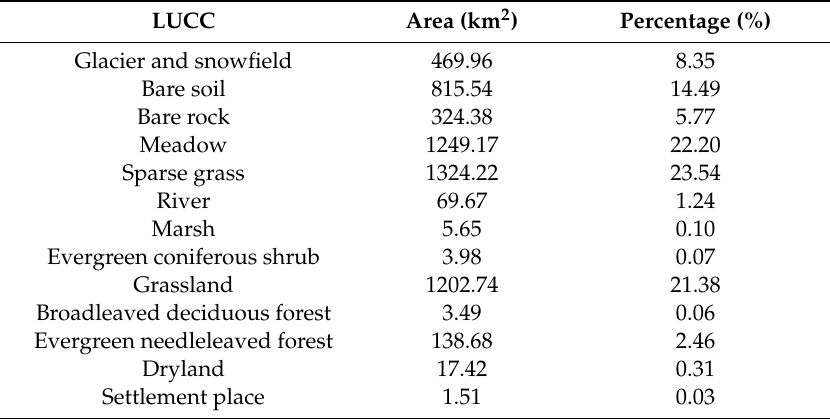
Table 1. LUCC statistics information table in the study